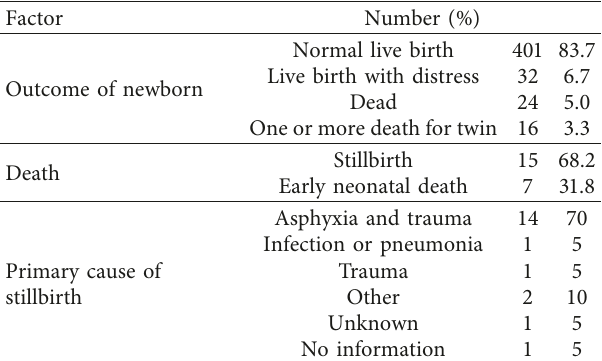
Figure 3: Types of staff members that performed the cesarean section in two hospitals, July 2015–June 2016 ( n Table 1: Immediate newborn outcome of CS delivery from July 2015 up to June